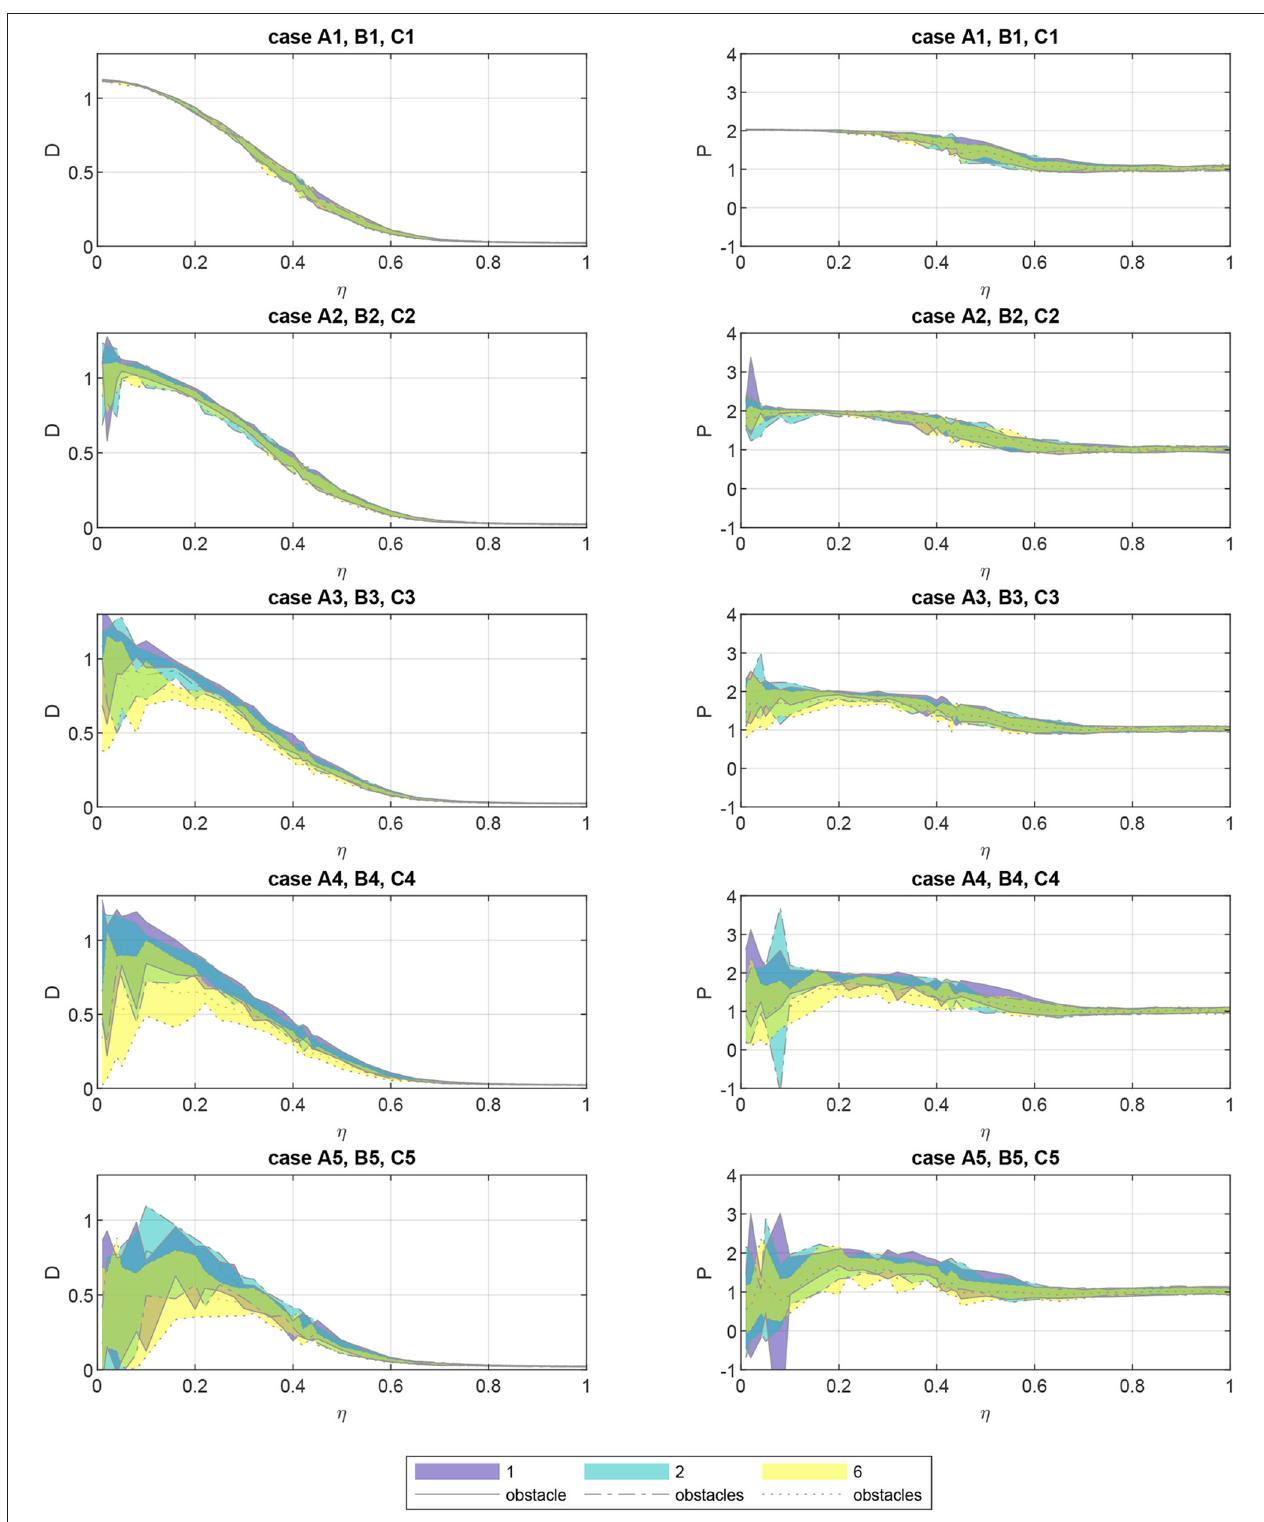
FIGURE 4 | Diffusion coefficient D (left plots) and the diffusion exponent P (right plots) as a function of the noise amplitude η for the fifteen obstacle cases. Cases are indicated in figure titles. Cases are grouped by the number of obstacles by color (see legend), and are placed on the same subplot when obstacles (whether 1, 2, or 6) are approximately the same size. The individual obstacle size increases for lower subplots. Shaded regions indicate mean Carlo